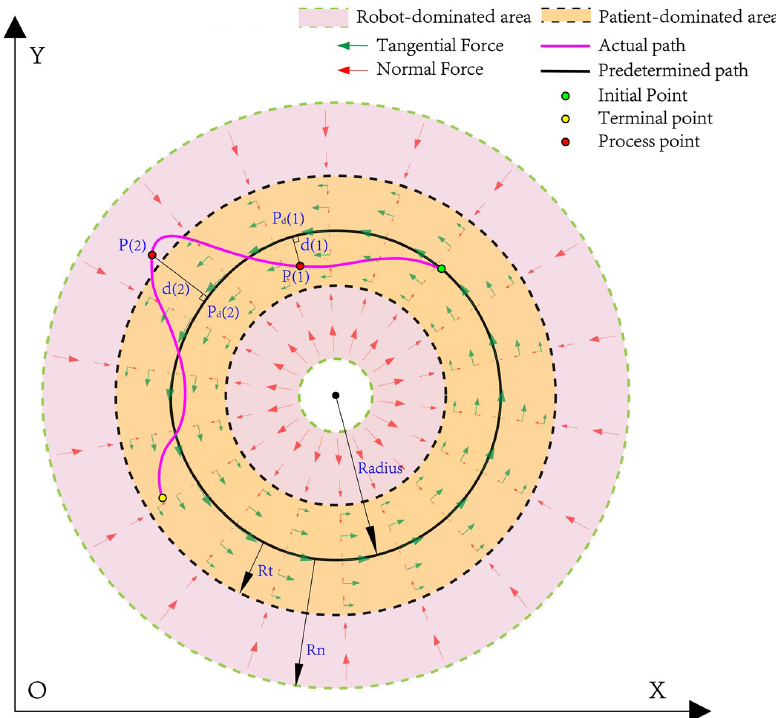
Figure 1. Two force-field areas divided according to the position deviation and the schematic diagram of the force distribution.